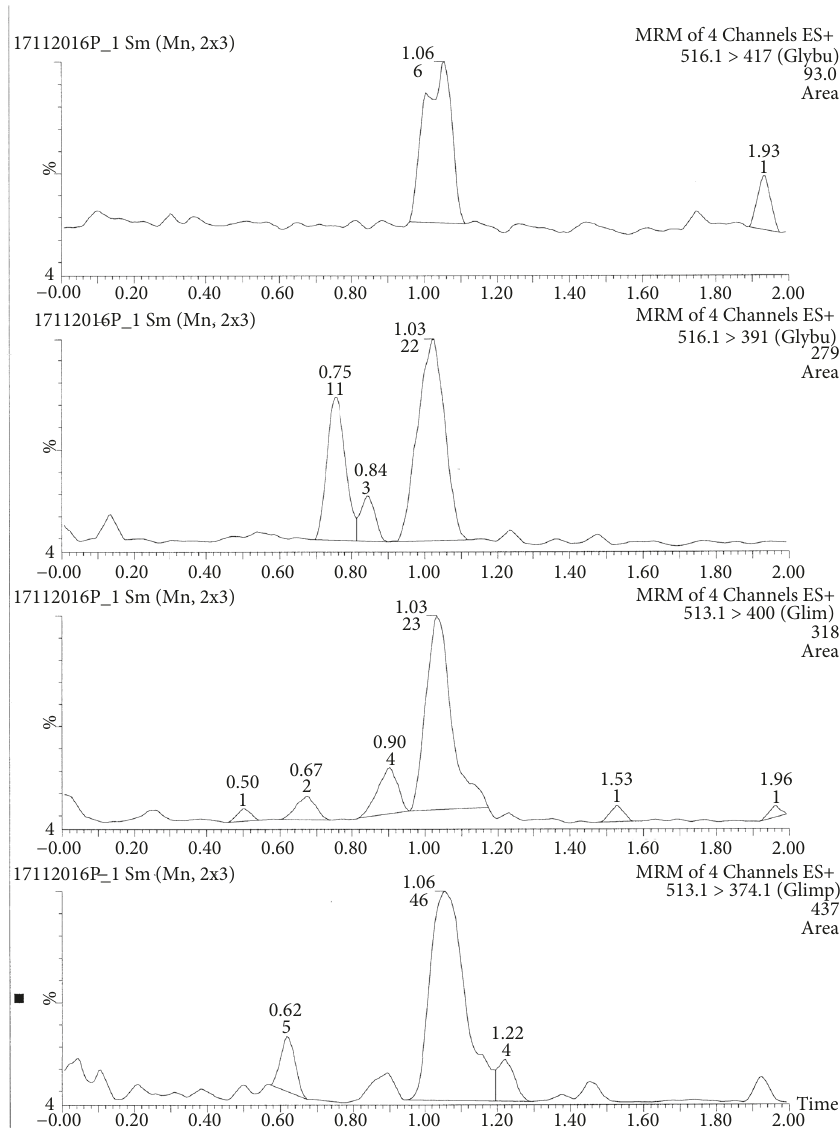
Figure 6: The representative chromatograms of blank plasma sample.